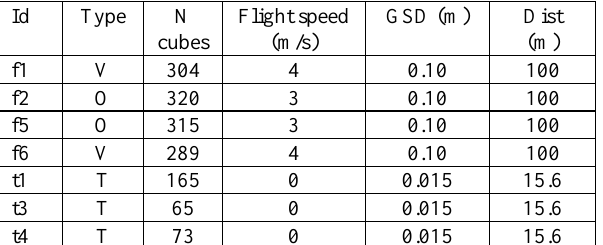
Table 2. Solar angles, imaging time and exposure information. Azimuth